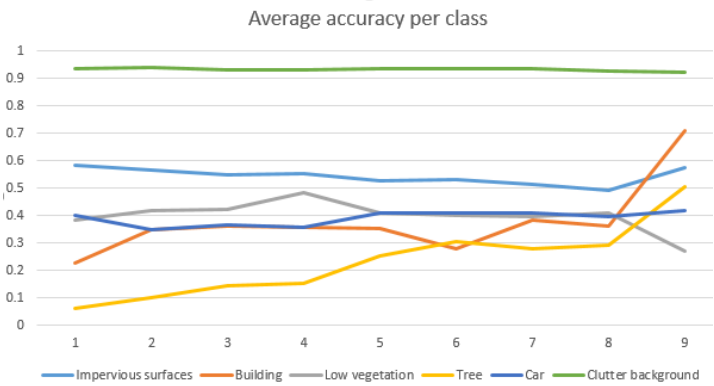
Figure 13. Improvement of average accuracy on the target dataset after each epoch.